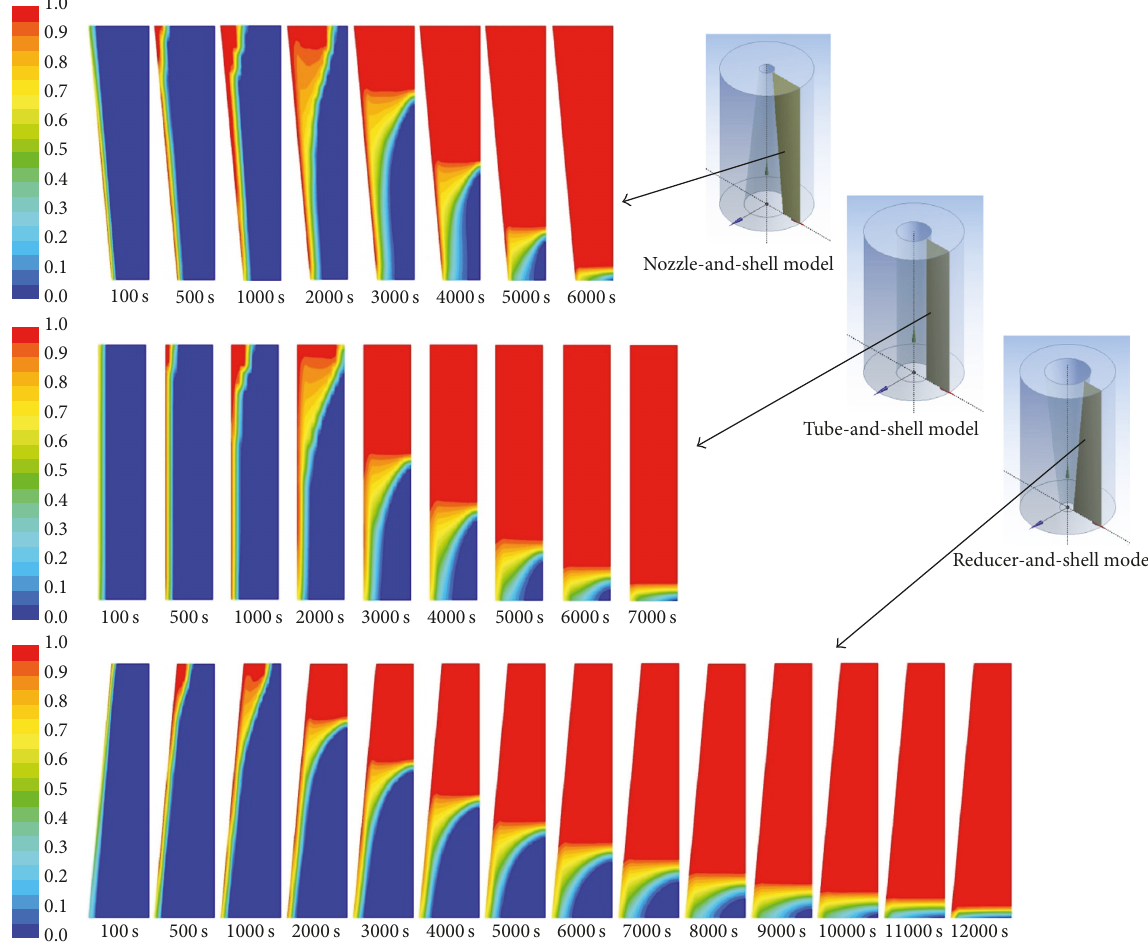
Figure 8: Contours of liquid-solid